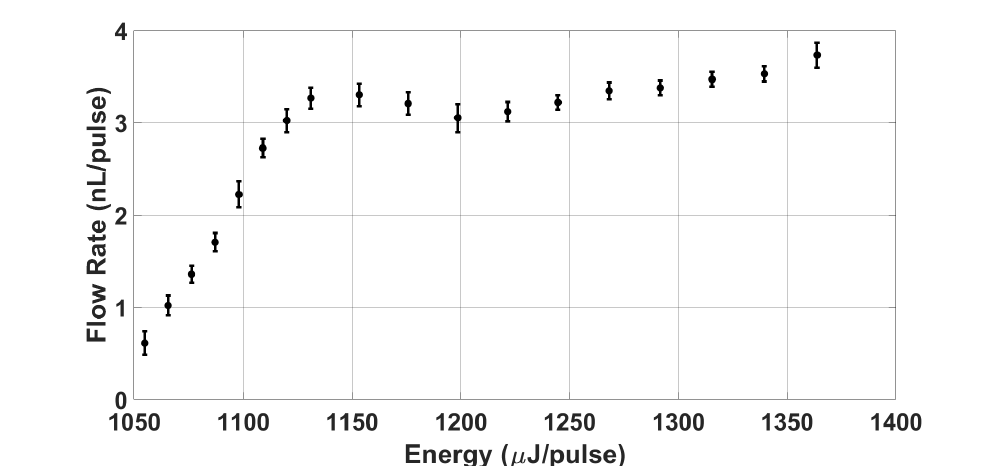
Figure 11. Micro-Pump Flow Rate vs. Energy Analysis—shows the flow rate saturation be- havior of thermal bubble-driven micro-pumps. A 300 × 700 µ m 2 FTO 8 Ω /sq TMP resistor of R = 45.9 Ω is placed 1027 µ m from the end of a length L = 13.268 mm channel of cross-sectional area A = 515 × 315 µ m 2 as shown in Figure 6a. Firing voltage was varied from 98.50 to 112 V with a 5 µ s pulse duration corresponding to energies of 1055 to 1364 µ J/pulse. The firing frequency was 20 Hz. At the lower bound, the flow rate becomes 0 when applied energy no longer forms a vapor bubble; at the upper bound, the flow rate slightly increases with applied energy until the resistor burns out and